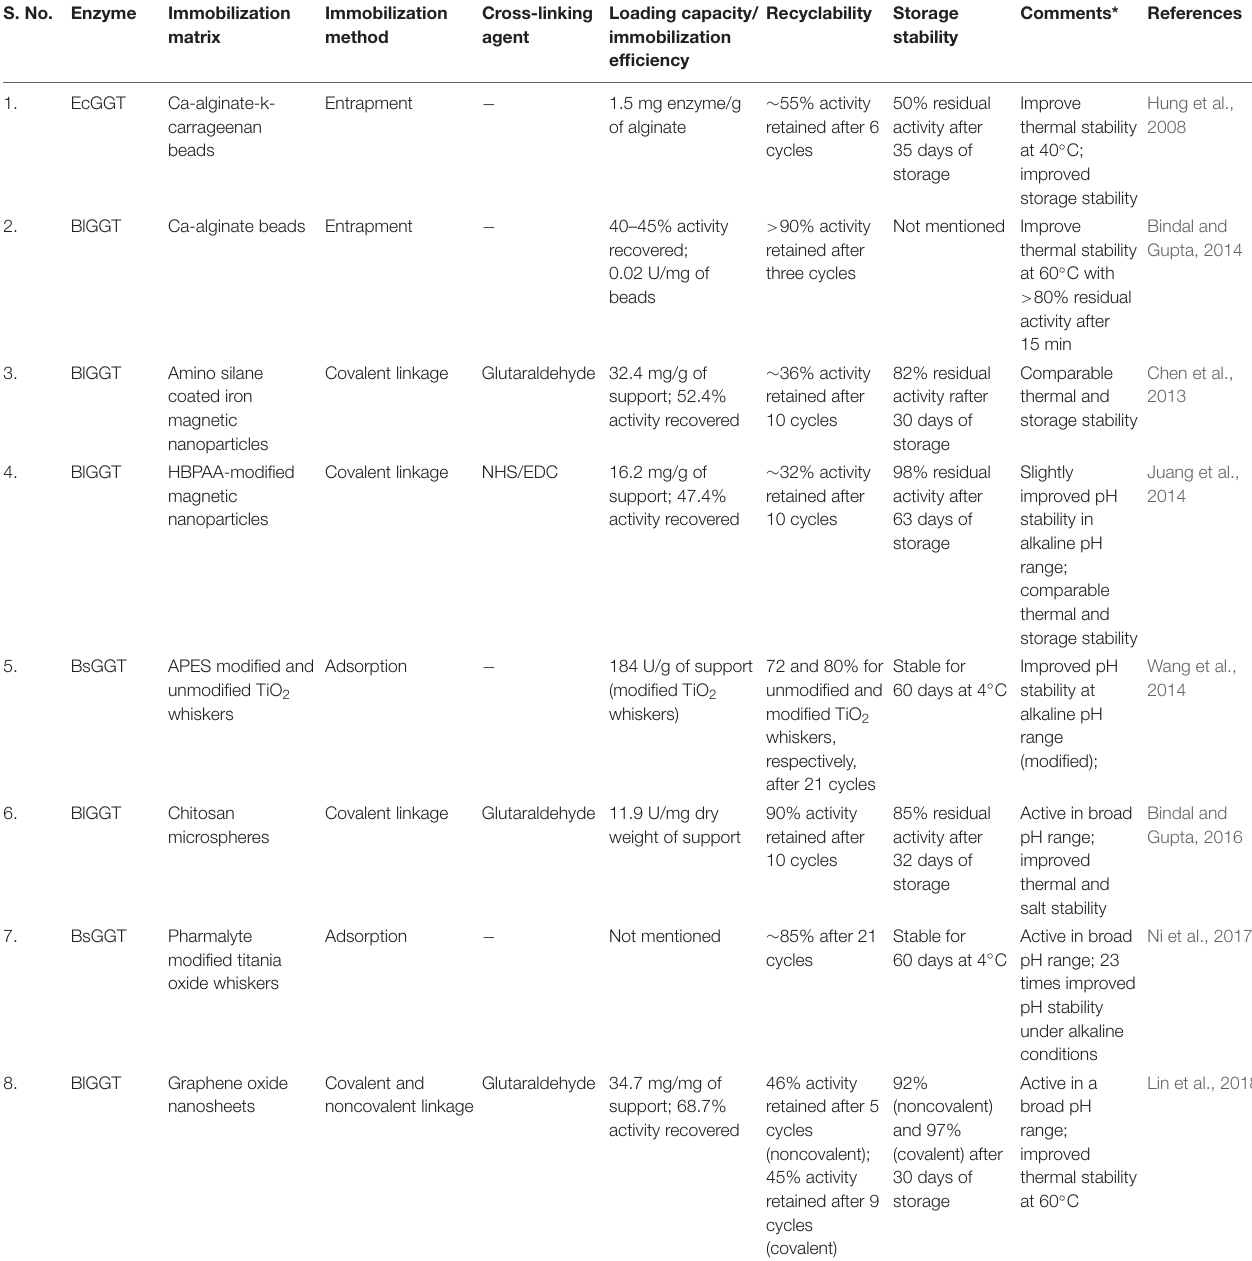
TABLE 5 | Immobilization of bacterial gamma-glutamyl transpeptidases (GGTs) on different matrices. S. No.